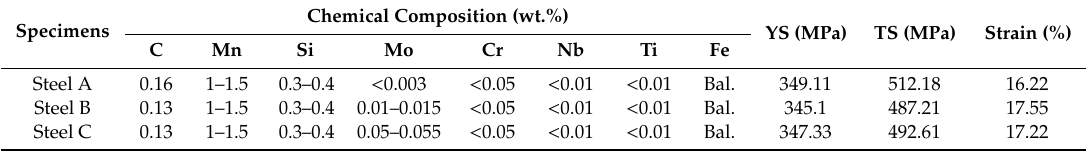
Table 1. Chemical compositions and mechanical properties of the three tested steel samples. Chemical Composition Specimens